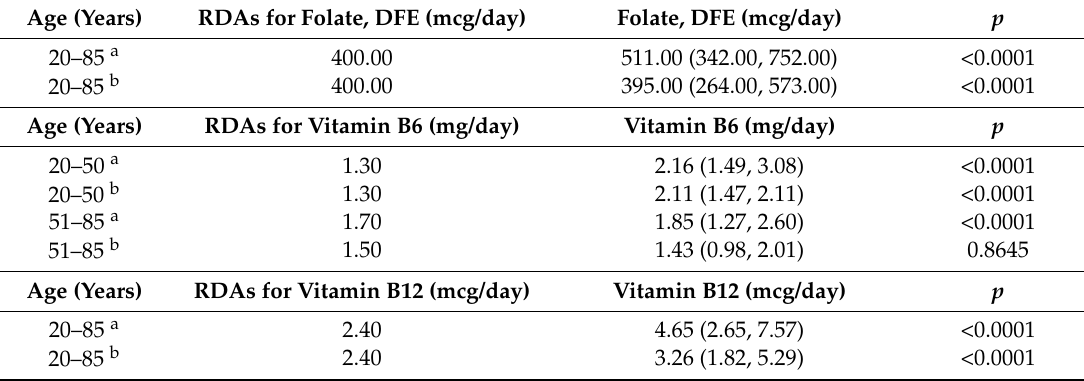
Table 1. B-vitamin intake among US adults (>19 years) in NHANES 2001–2014.